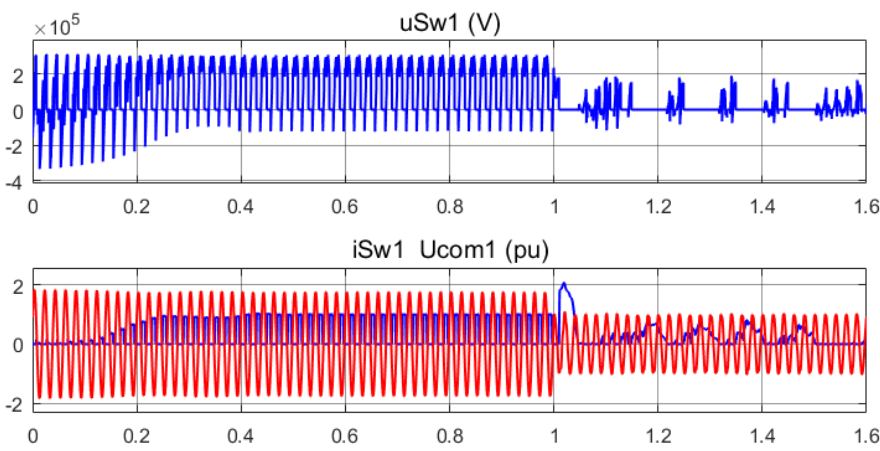
Figure 14. The faulted signal after 1 s at both rectifier (transmitting point) and inverter (receiving point).